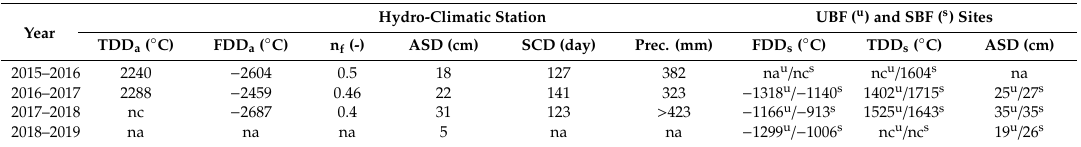
Table 3. Overview of the climatic variability during the period of soil temperature and moisture observations in the pits. The hydrological years include complete freezing and thawing seasons (na—not available; nc—not